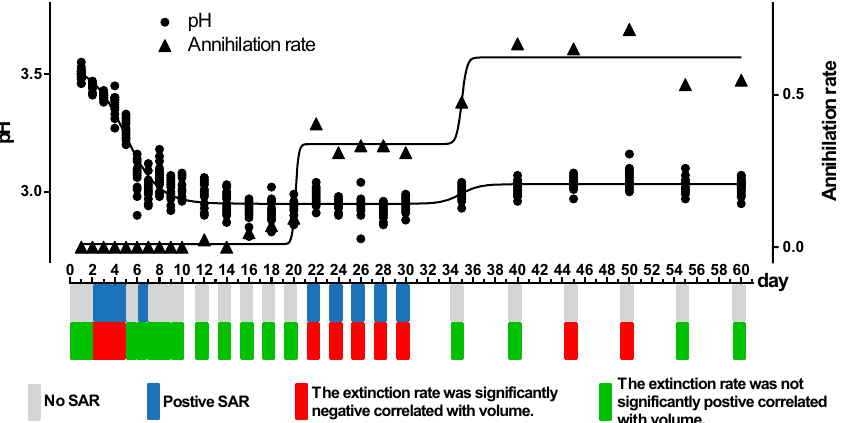
Figure 3. Sixty-day pH values and annihilation rates of the microcosm system, the SAR at each time point, and the relationship between extinction rate and volume. The regression line is from the model with a bell- shaped form (pH: p = 0.048, R 2 = 0.927; annihilation rate: p = 0.045, R 2 = 0.976). A grey block indicates that there